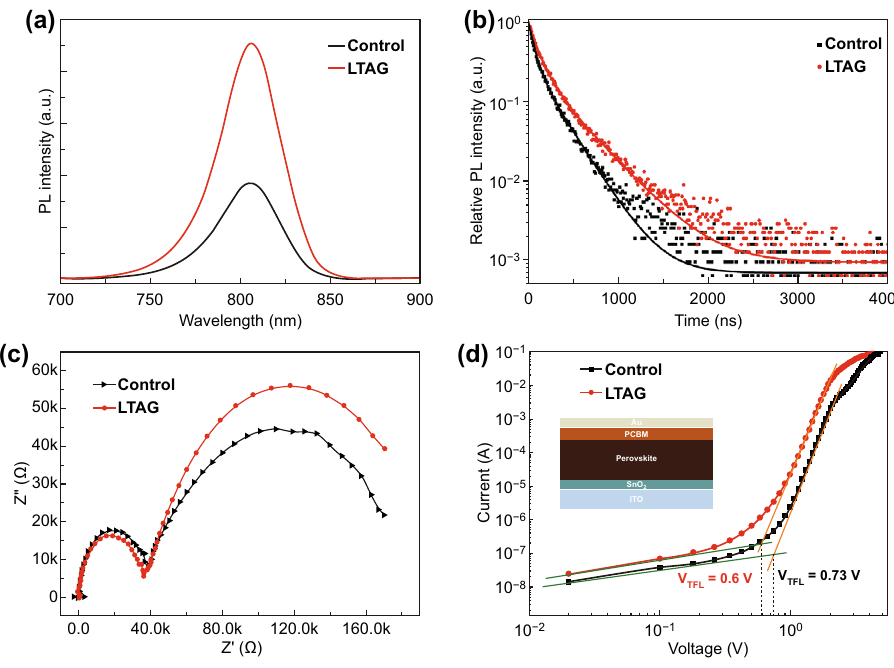
Fig. 4 a Steady‑state PL spectra of annealed perovskite layers prepared without (control) and with LTAG treatment at 30 °C. b TRPL spectra of the control and LTAG‑based perovskite films. c Nyquist plots for the control and LTAG‑based perovskite devices in the dark. d Current–volt‑ age curves and extracted defect densities of electron‑only devices prepared using the control and LTAG‑based methods; insets: the single‑carrier device